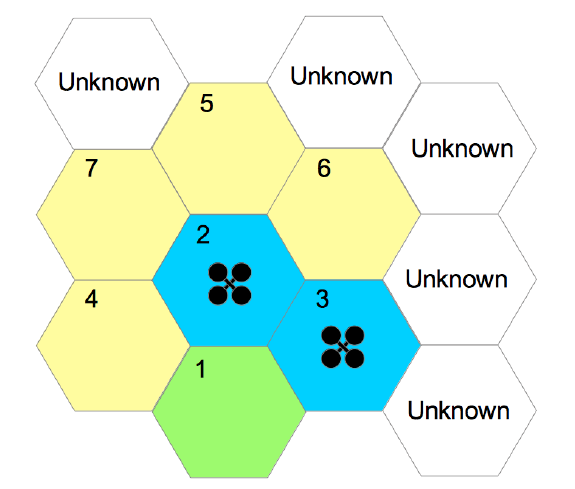
Figure 3. Multiple UAV exploration: green hexagon, explored place; yellow hexagons, places that have adjacency, but not yet explored; blue hexagons, places that are explored by UAV; white hexagons, unknown places that are mapped in future